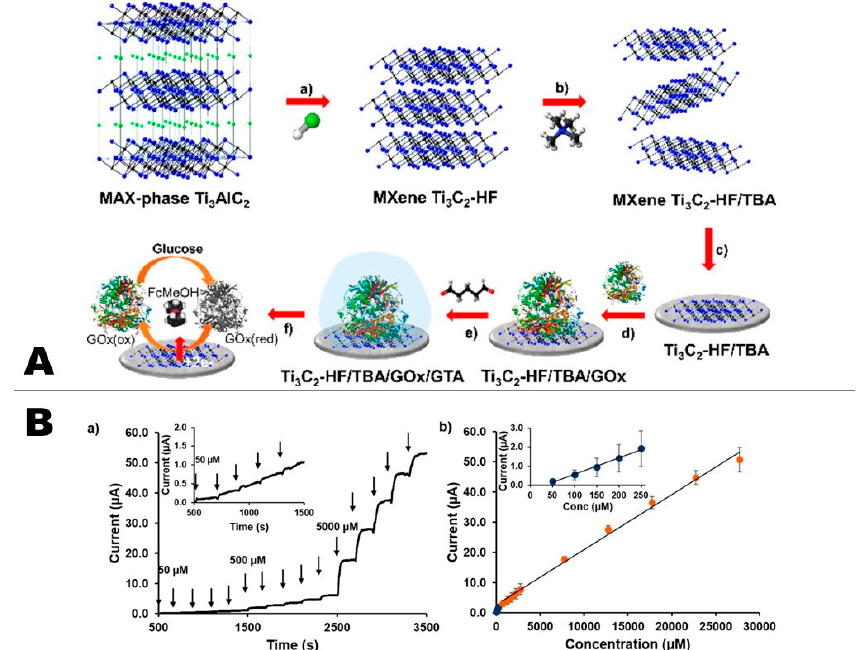
Figure 3. ( A ) Schematic illustration of sensor fabrication; ( a ) exfoliation of Ti 3 AlC 2 via etching with HF; ( b ) delamination with TBAOH; ( c ) modifying the glassy carbon electrode with MXene; ( d ) loading of glucose oxidase (GOx), and; ( e ) cross-linking glutaraldehyde (GTA) with GOx; ( f ) glucose detection mechanism of the proposed biosensing system. ( B ) Chronoamperometry data ( a ) and calibration plot ( b ) for Ti 3 C 2 –HF/TBA-based electrochemical glucose biosensor conducted using FcMeOH (2 mM) in pH 7.2 PBS (electrolyte) and 0.15 V potential (reproduced with permission from reference [64]).